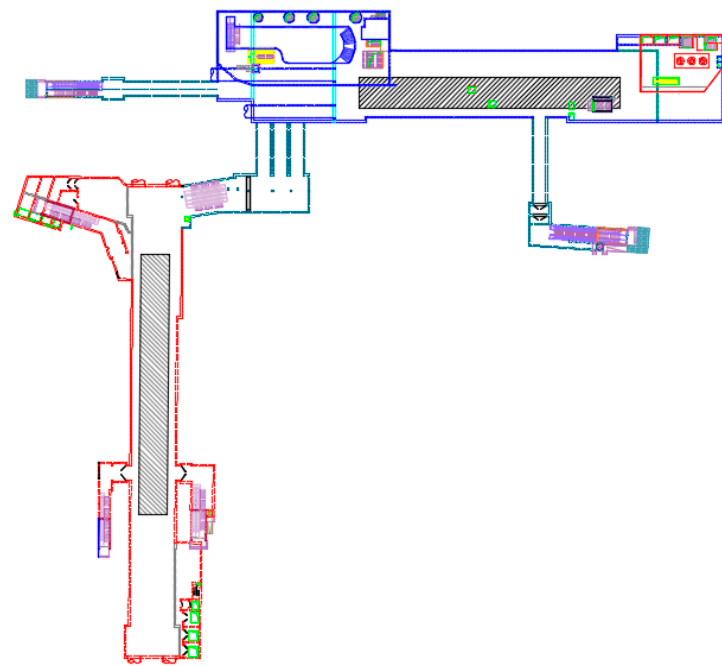
Figure 3. Plane design of the target study station.